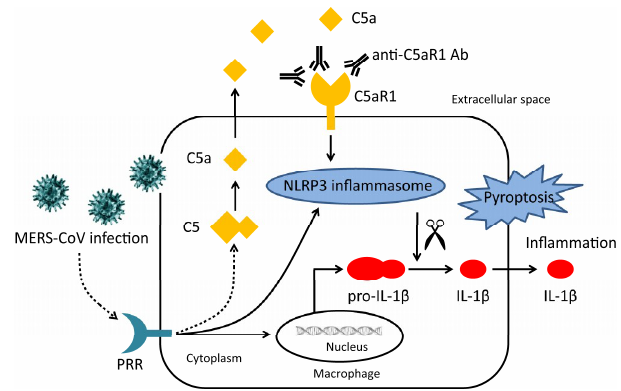
Figure 7. Diagram illustrating the relationship between complement and pyroptosis during MERS-CoV infection. MERS-CoV infection induces activation of complement and transcription of pro-IL-1 β . Activated complement component C5a is released into the extracellular space where it interacts with C5aR1, which triggers assembly of the NLRP3 inflammasome. Activated caspase-1 cleaves pro-IL-1 β into its active form thereby triggering pyroptosis. An anti-C5aR1 antibody prevents interaction between C5a and C5aR1, thereby ameliorating